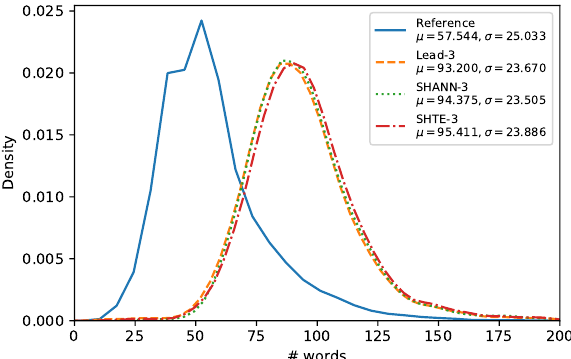
Figure 4. Word-length distribution of system generated summaries in comparison to human reference summaries for